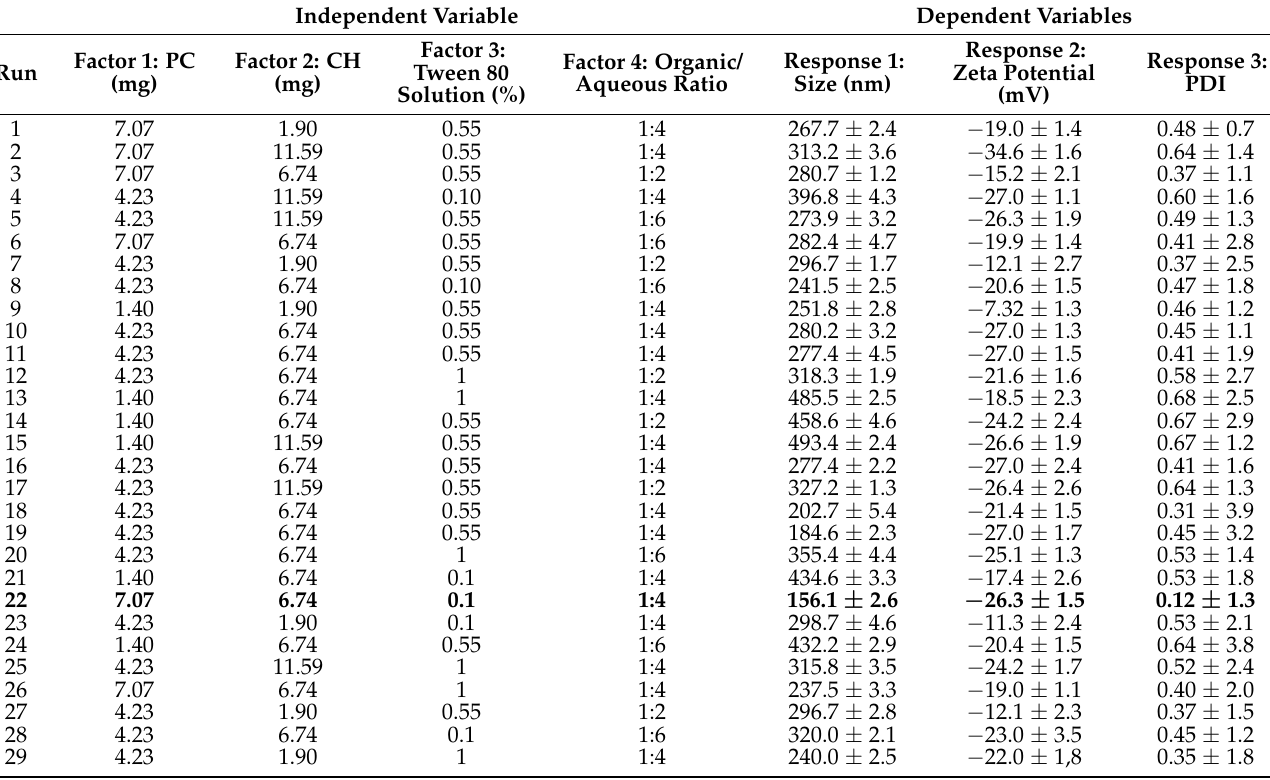
Table 2. Optimization of LP using Design